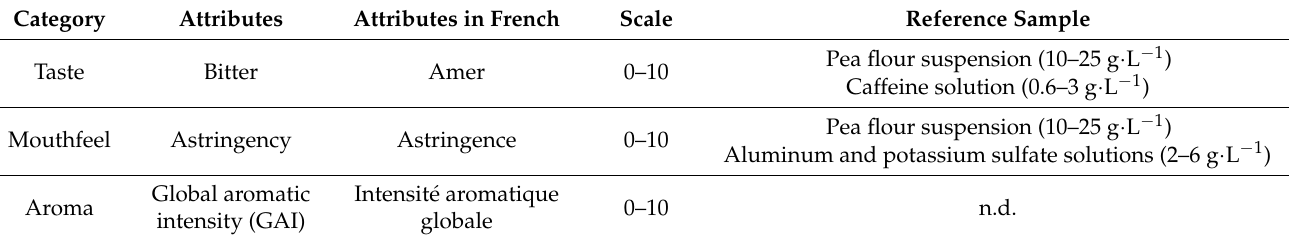
Table 2. Sensory attributes explored in the quantitative descriptive analysis within their sensory categories, scale and reference samples used in the training